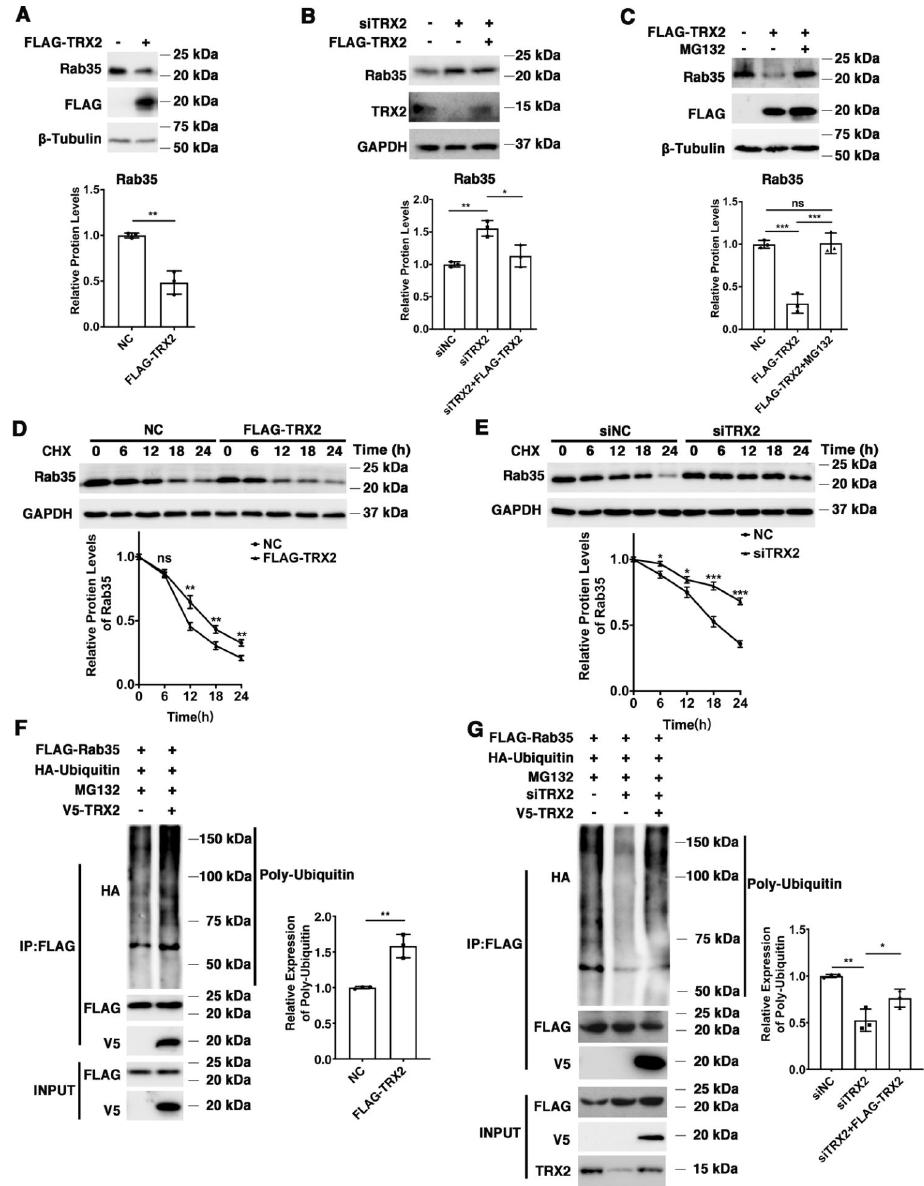
Figure 4. TRX2 induced Rab35 ubiquitination and degradation. ( A ) HCT116 cells were transfected with pcDNA3.1+ or FLAG − TRX2. Rab35 was detected by WB. ( B ) HCT116 cells were transfected with siNC, siTRX2, or siTRX2, plus low levels of FLAG − TRX2. Rab35 was detected by WB. ( C ) HCT116 cells were transfected with pcDNA3.1+ or FLAG − TRX2 and treated with or without MG132. Rab35 was detected by WB. ( D ) HCT116 cells were transfected with pcDNA3.1+ or FLAG − TRX2 − and treated with cycloheximide (CHX) for the indicated times. Rab35 was detected by WB. ( E ) HCT116 cells were transfected with siNC or siTRX2 and treated with CHX for the indicated times. Rab35 was detected by WB. ( F ) HCT116 cells were transfected with V5 − TRX2, FLAG − Rab35, or HA − tagged ubiquitin. After 48 h, the cells were treated with MG132. The ubiquitination of Rab35 was detected by IP. ( G ) HCT116 cells were transfected with FLAG − Rab35, HA − tagged ubiquitin, siTRX2, or siTRX2, plus low levels of V5 − FLAG. After 48 h, the cells were treated with MG132. The ubiquitination of Rab35 was detected by IP. The experiments were performed for three biological replicates. The error bars represent means ± SD. * p < 0.05, ** p < 0.01, and *** p < 0.001 using the t test or one − way ANOVA with Š í d á k’s multiple comparisons